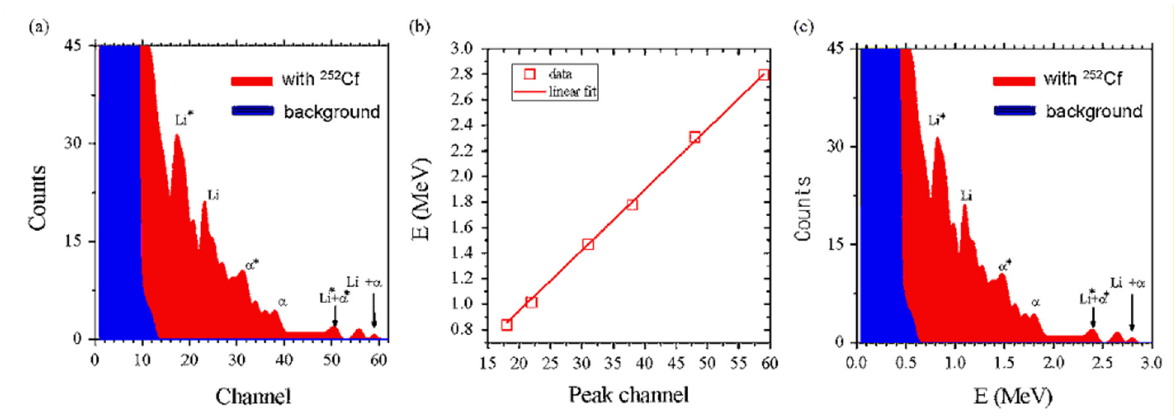
Figure 10. ( a ) Counts versus channel number, ( b ) energy peak calibration among all expected nuclear reaction products, and ( c ) counts vs. energy (MeV) (the figures are reproduced from [83] copyright 2013, with permission from Elsevier).